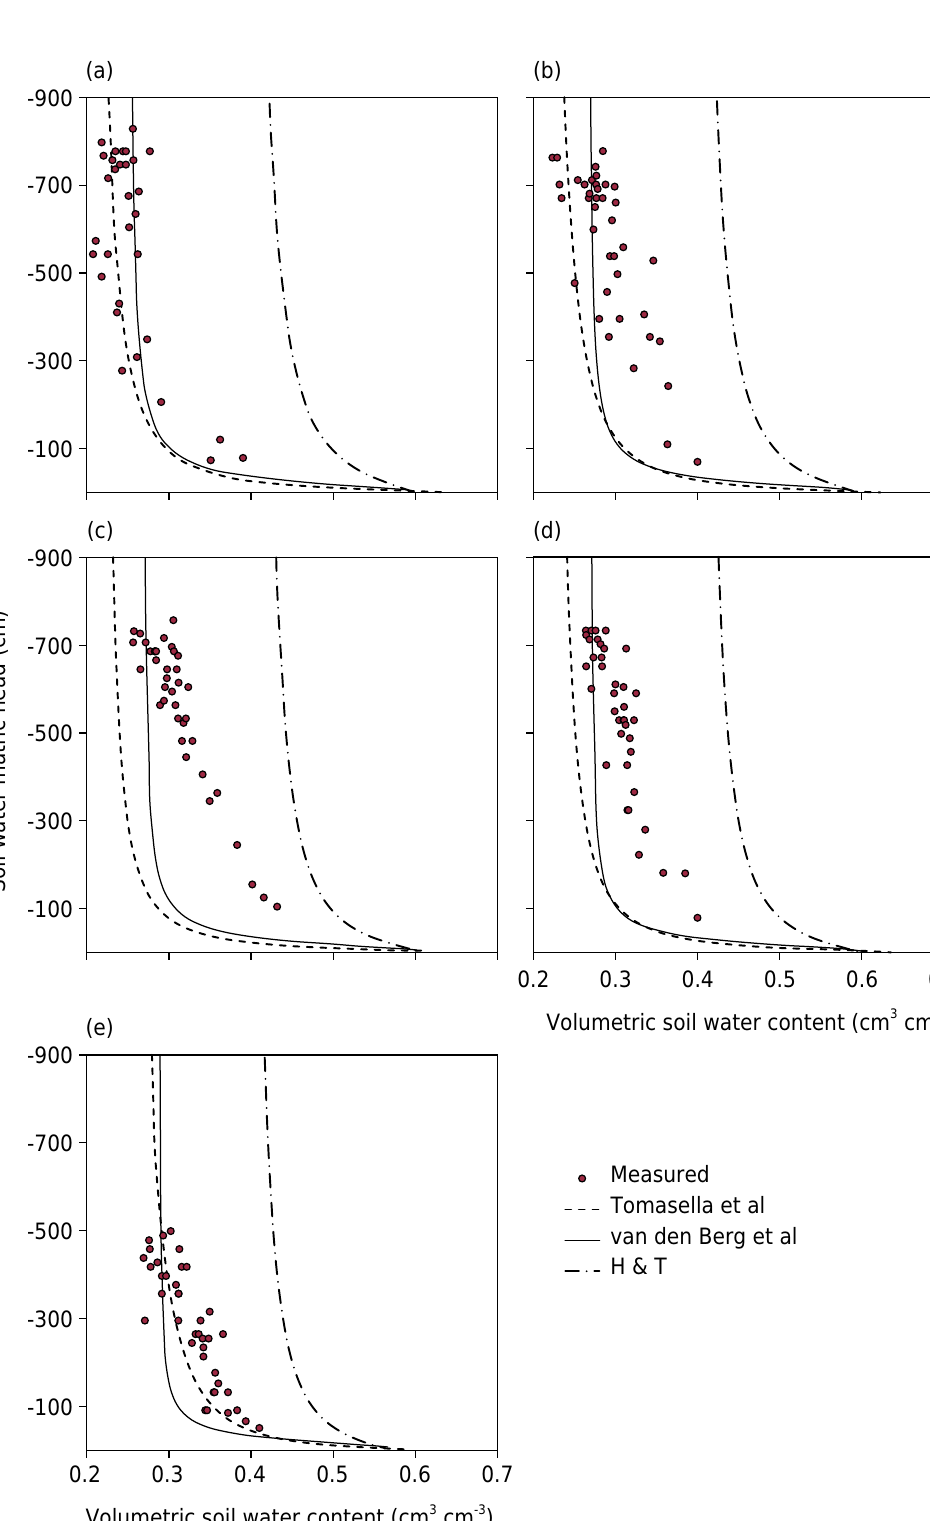
Figure 4. Functional relationships h ( θ ) of the soil profile obtained with pedotransfer equations and comparison with the point values determined in the present study. Tomasella et al refers to the equations proposed by Tomasella et al. (2003); van den Berg et al refers to the equations proposed by van den Berg et al. (1997); and H&T refers to the equations proposed by Hodnett and Tomasella (2002). (a) 0.15 m depth; (b) 0.30 m depth; (c) 0.45 m depth; (d) 0.60 m depth; and (e) 0.90 m